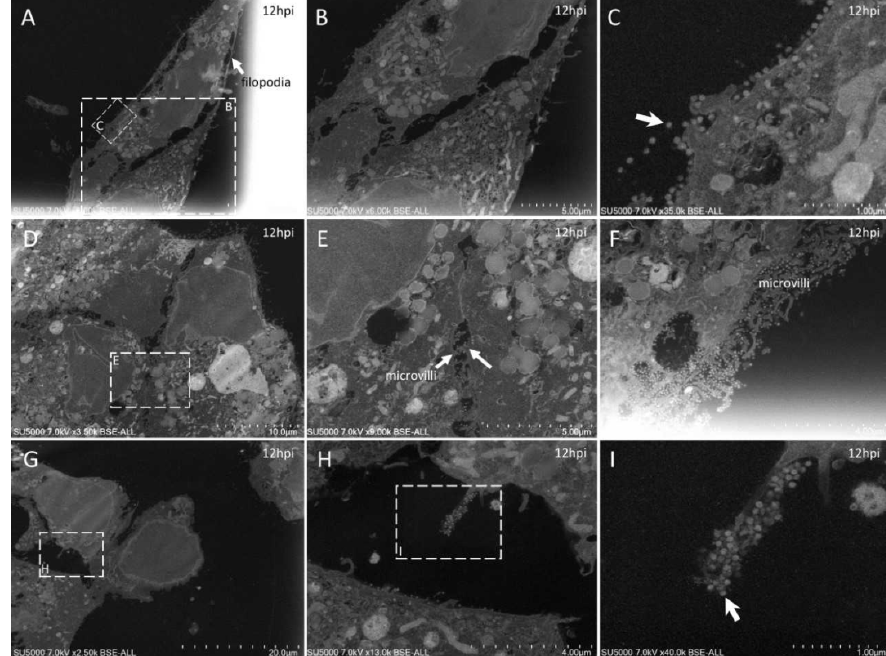
Figure 4. Ultra-thin sections of SARS-CoV-2-infected Vero E6 cells: 12 hpi. ( A – C ): Two neighboring cells, one with a long filopodia ( A , B ; arrow A ) and one presenting extracellular SARS-CoV-2 particles at the plasma membrane ( C ; arrow). ( D – F ): SARS-CoV-2-enriched microvilli located between neighboring cells ( E ; arrows) or at the cell-free periphery ( F ). ( G – I ): One microvillus extremely enriched in SARS-CoV-2 virions ( I ; arrow).